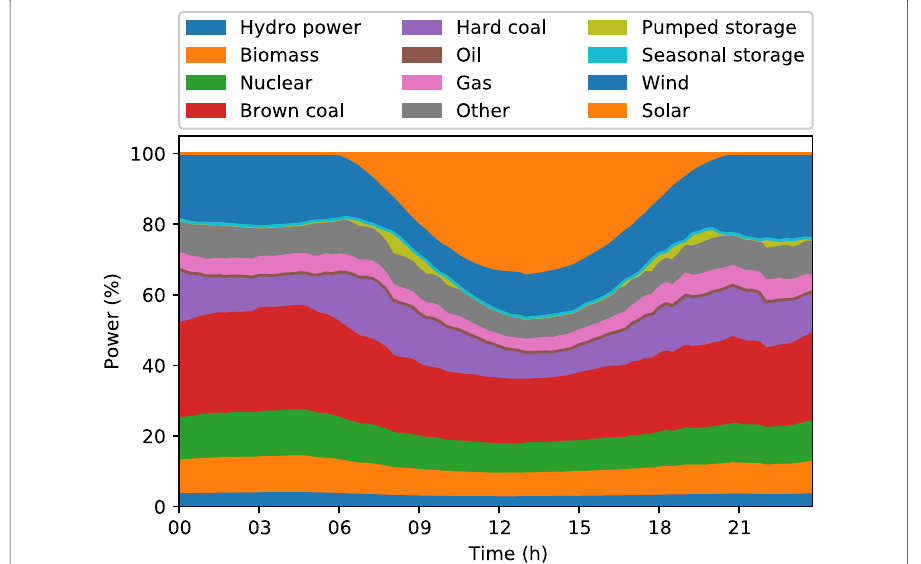
Fig. 1 German generation mix in 19 July 17.